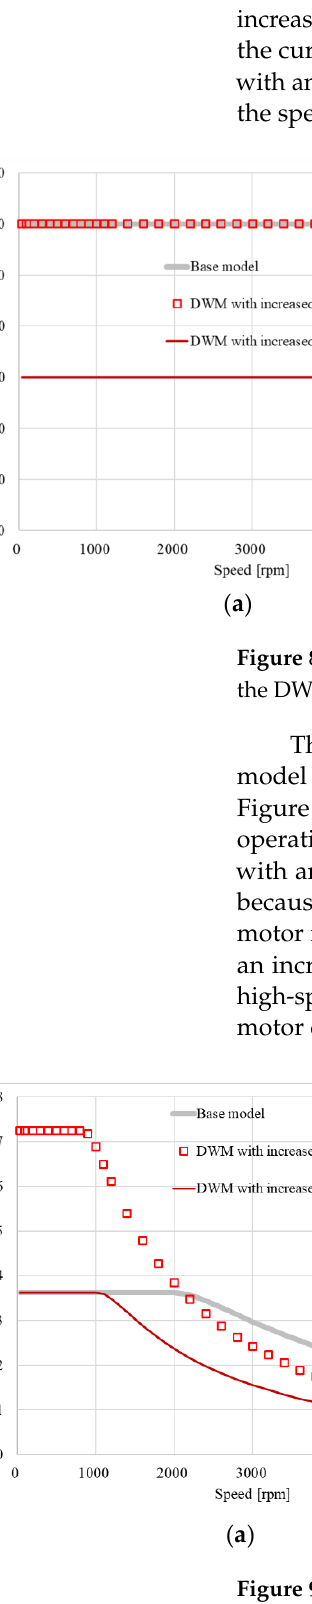
Figure 10. Current vector control strategy for DWM using Simulink. The concept of the power transmission path from the pressure load of the IEB to the motor torque load is illustrated in Figure 11. Equation (9) was used to convert the pressure load to the motor torque load in the response analysis [30]. C o n t r o l l er 1 f o r m a s t er p a r t C o n t r o ll er # f o r s l av e p a r t D u a l i n v e r t er